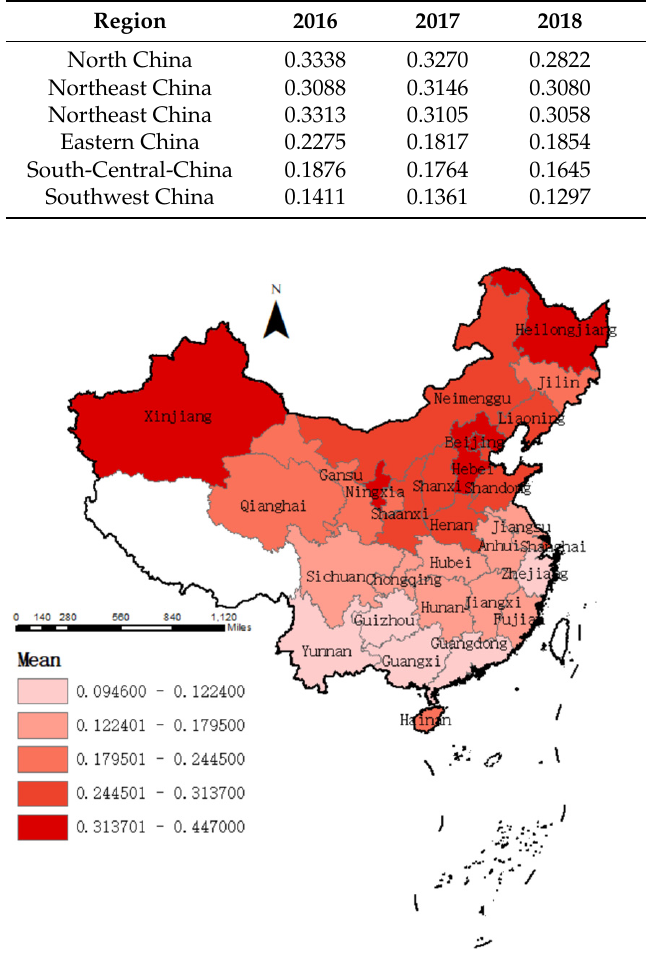
Figure 1. The mean level of water vulnerability of each province. Table 2. Descriptive statistics of water vulnerability.